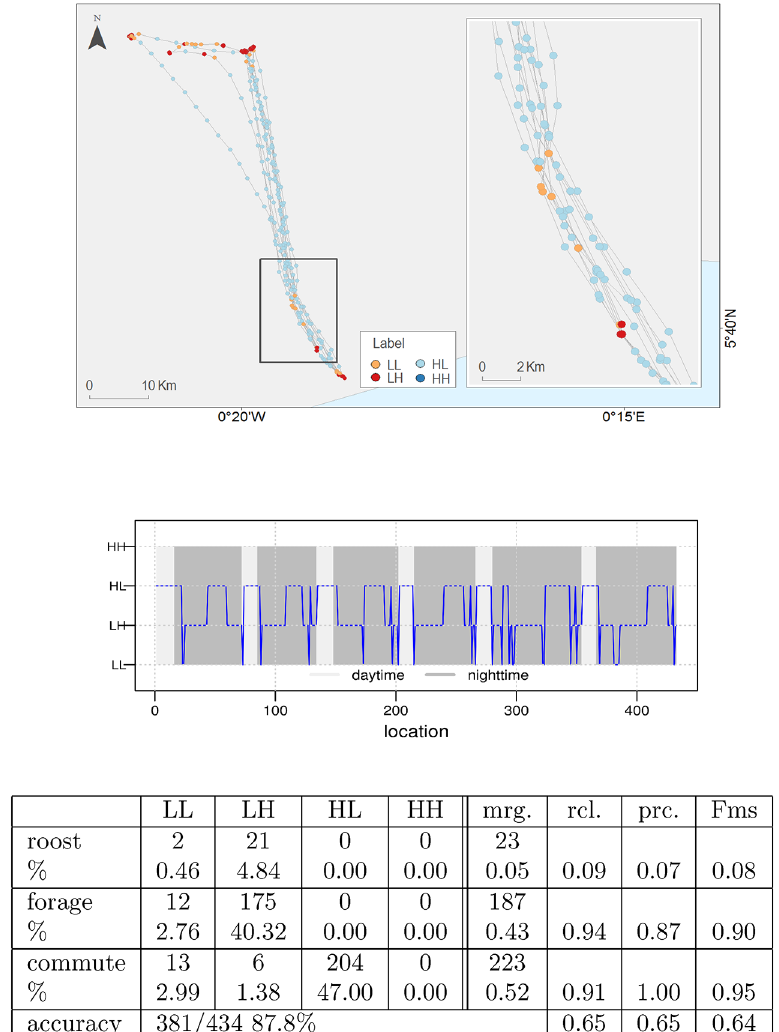
Fig 9. Bat ( Eidolon helvum ) foraging trajectory. Upper: Point-wise labelled foraging trajectory. Symbolization by label (LL:orange, LH:red, HL:cyan, HH:blue) and time spent (symbol size: 2 natural jenks). Scale bar is only approximate. Due to copyright restrictions the figure is for representative purposes only. Source: Made with Natural Earth; Free vector and raster map data @ naturalearthdata.com. Centre: smoothed temporal behavioural profile with daytime/night-time (light/dark grey) background indication. Bottom: Confusion pie showing expert vs . EMbC labelling. Column titles mrg ., rcl ., prc . and Fms stand for marginals , recall , precision and F-measure